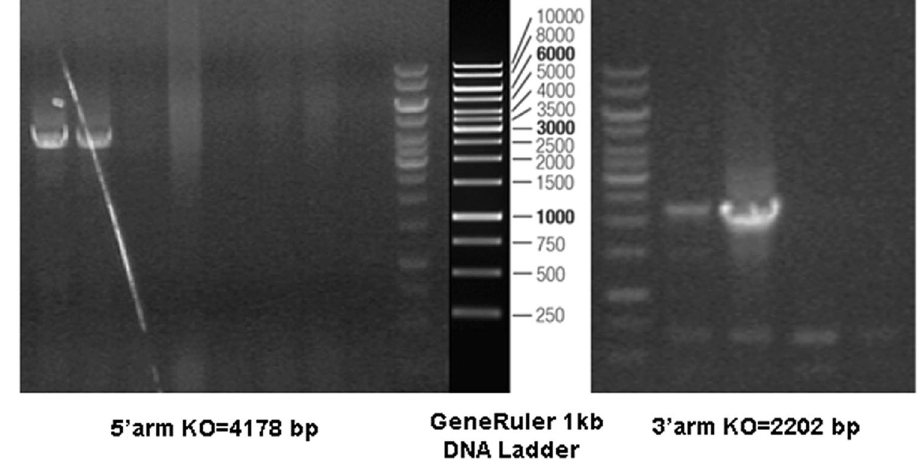
Figure 1. Identification of gene targeted ES cells. Ganciclovir resistance targeted ES clones were identified by PCR with the Neo-specific vector primer (P2, P3) and host genome-specific primers (P1 for GGNBP2 exon 3-specific, P4 for GGNBP2 intron 7-specific). Targeted clones were expected to produce both 4178 bp 5 ′ arm amplicon and 2202 bp 3 ′ arm amplicon. Only two clones were dual positive. The GeneRuler 1 kb DNA Ladder is a DNA Marker, and the numbers and bands between the two agarose gels were provided by the manufacturer (Thermo Scientific, #SM0312).